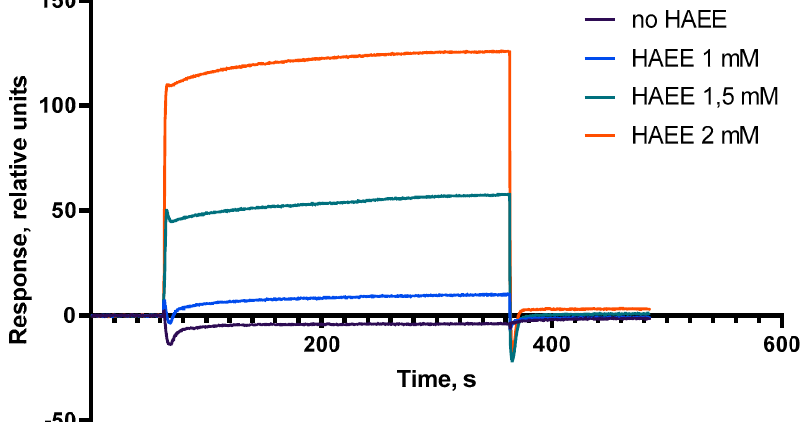
Figure 3. Sensorgrams showing direct binding of Ac-HAEE-NH 2 (1 mM–2 mM) to immobilized A β 16 . Spikes at the start and end of Ac-HAEE-NH 2 injections are due to a slight time delay in the reference cell and appear when reference subtraction is carried